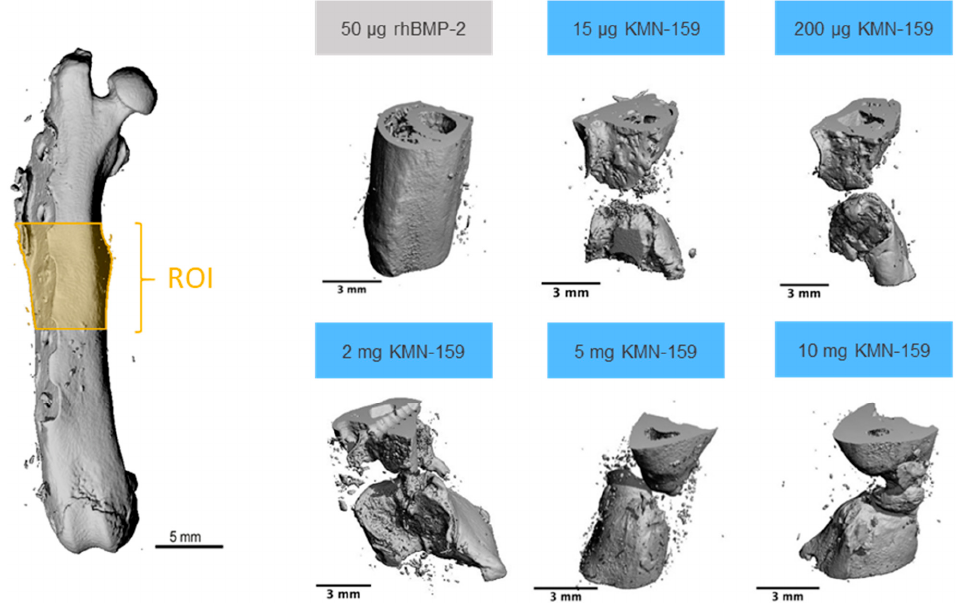
Figure 2. Representative examples of 3D reconstructions of the defect area (ROI) as determined by µCT.